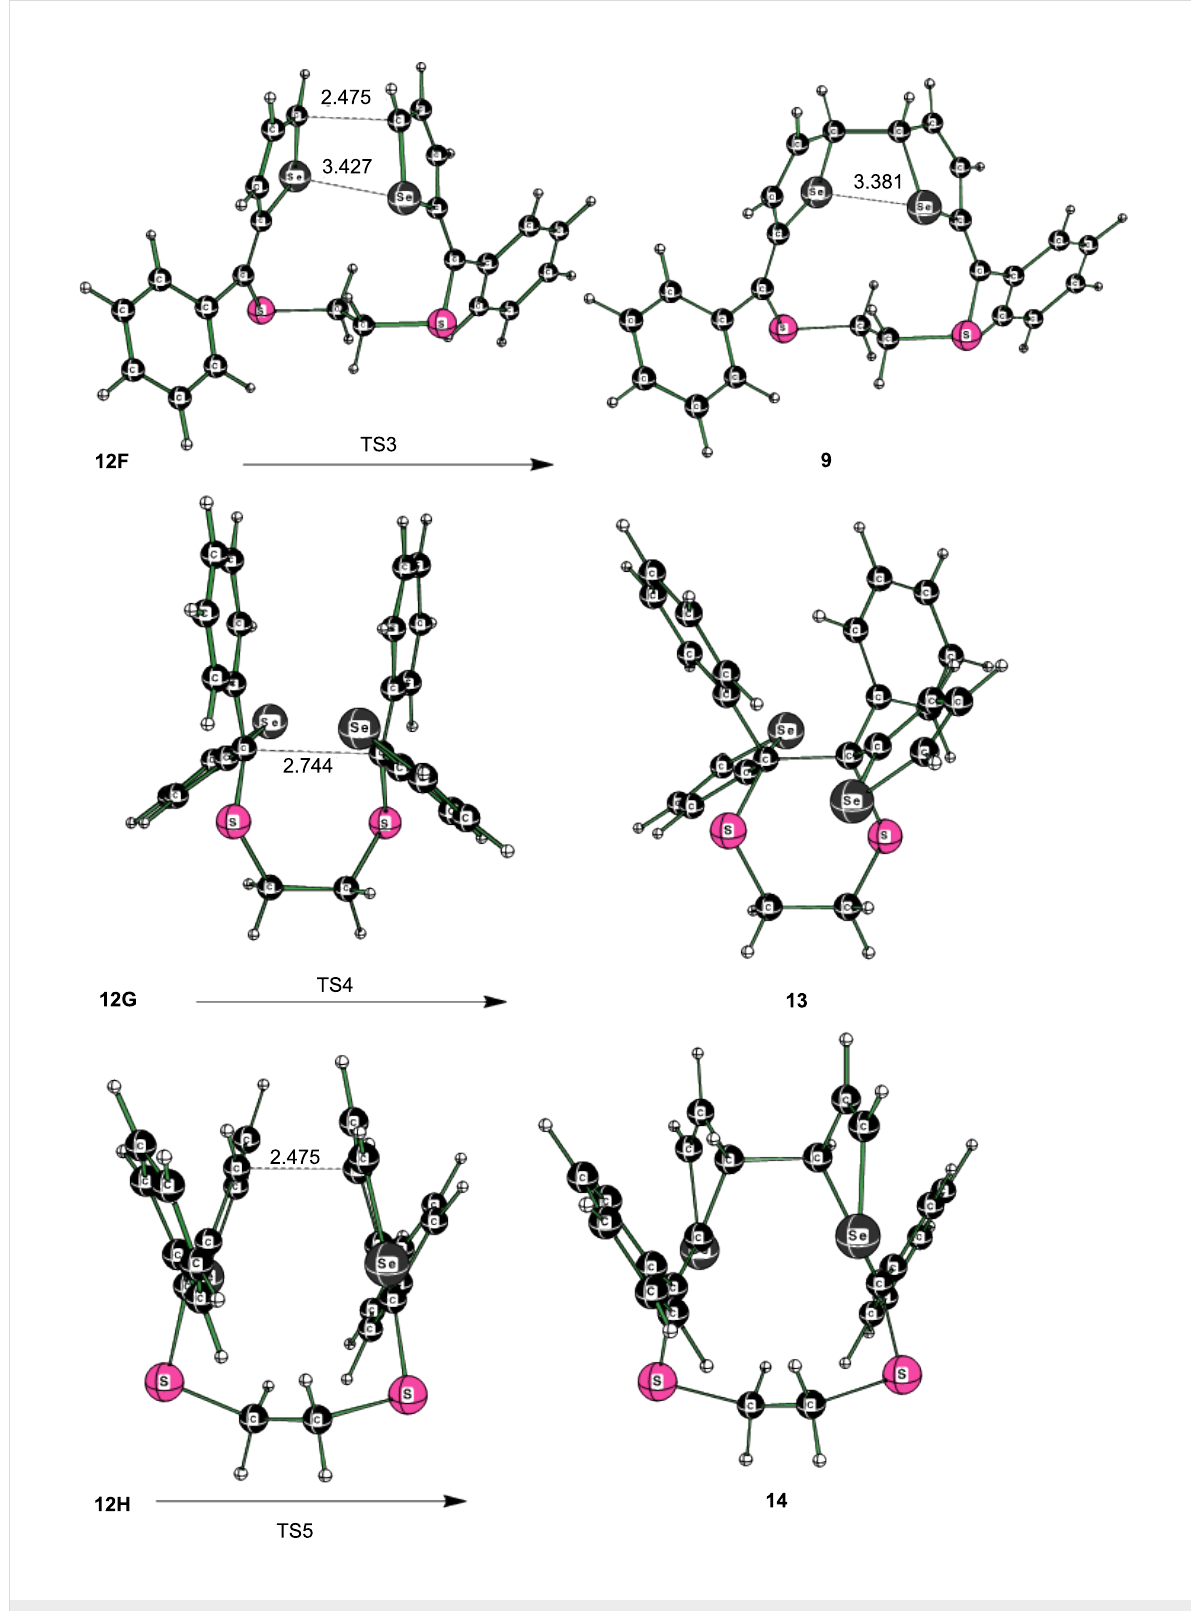
Figure 4: Potential competitive cyclization reactions of the intermediate diradical 12